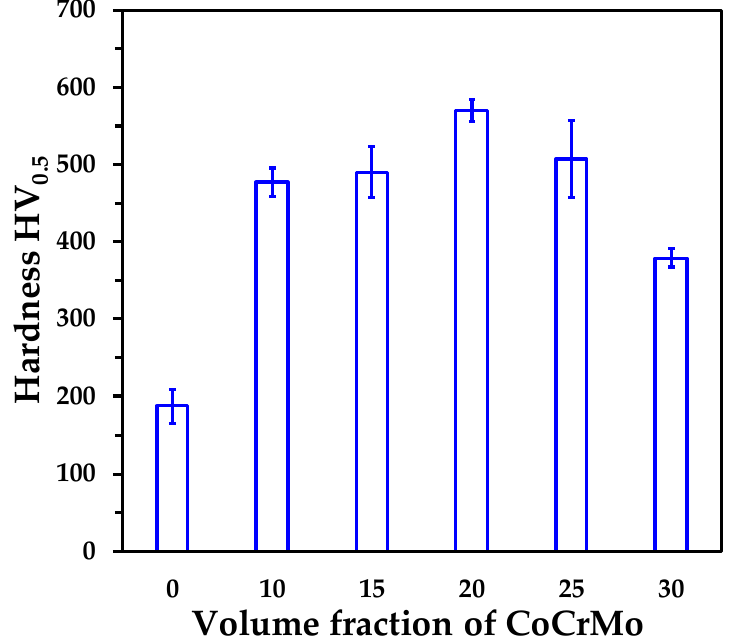
Figure 11. Average values of hardness for Ti6Al4V and composite samples sintered at 1130 °C.